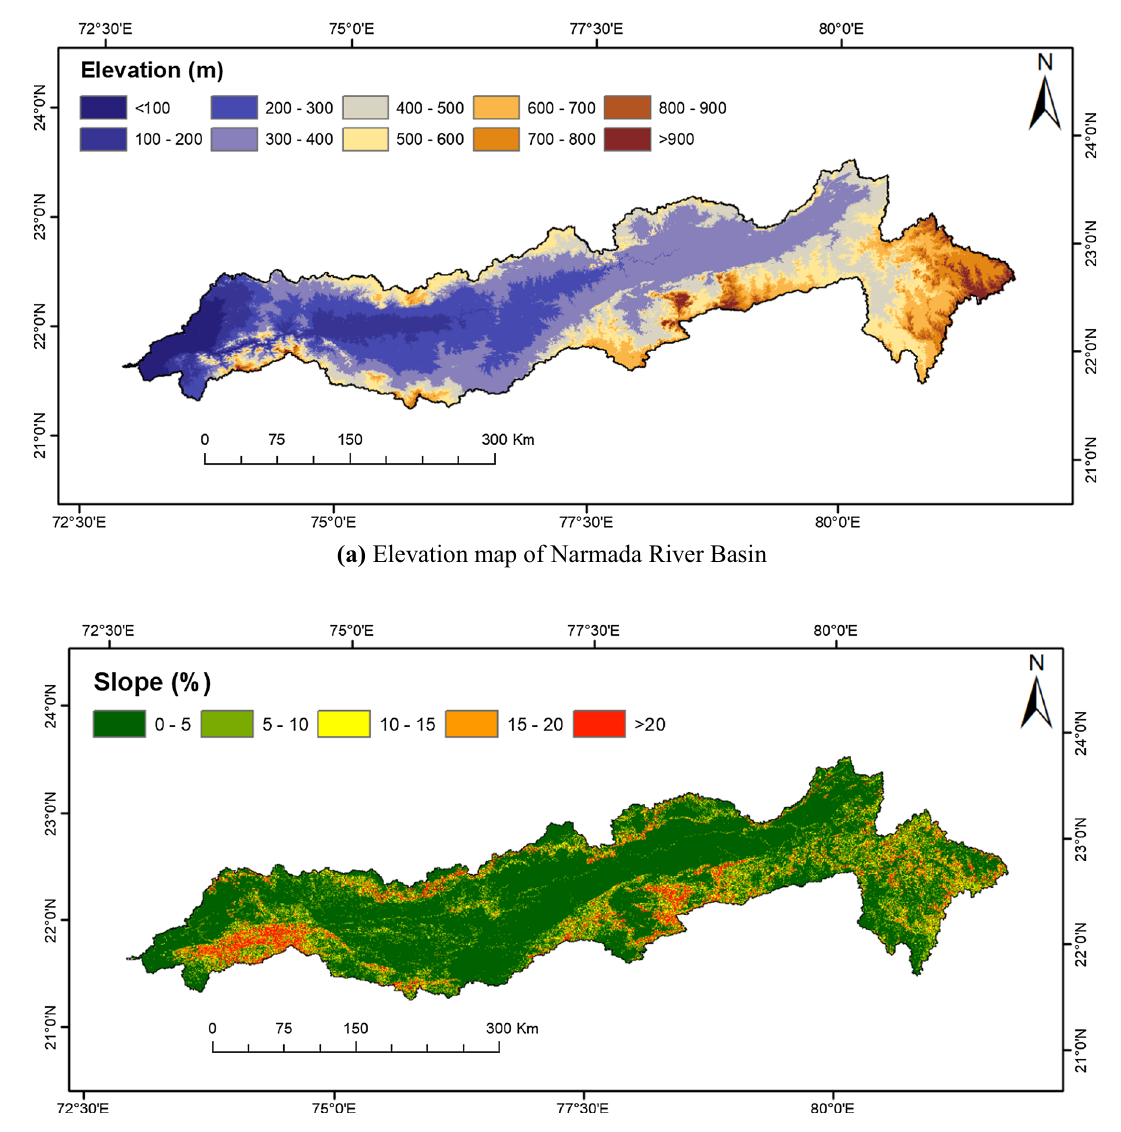
Fig. 10 Spatial variation of a elevation, b slope over Narmada River